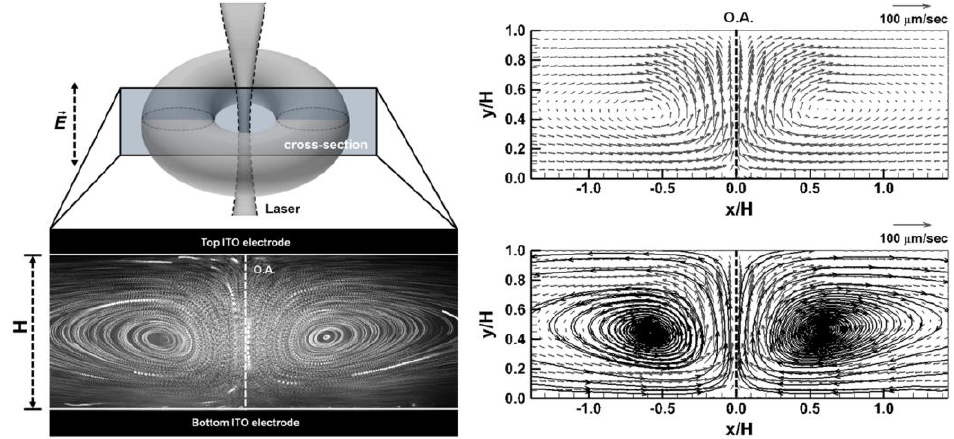
Figure 9. Visualization and particle image velocimetry (PIV) analysis of electrothermal microfluidic motion. Reprinted by permission from (the RightsLink Permissions Springer Customer Service